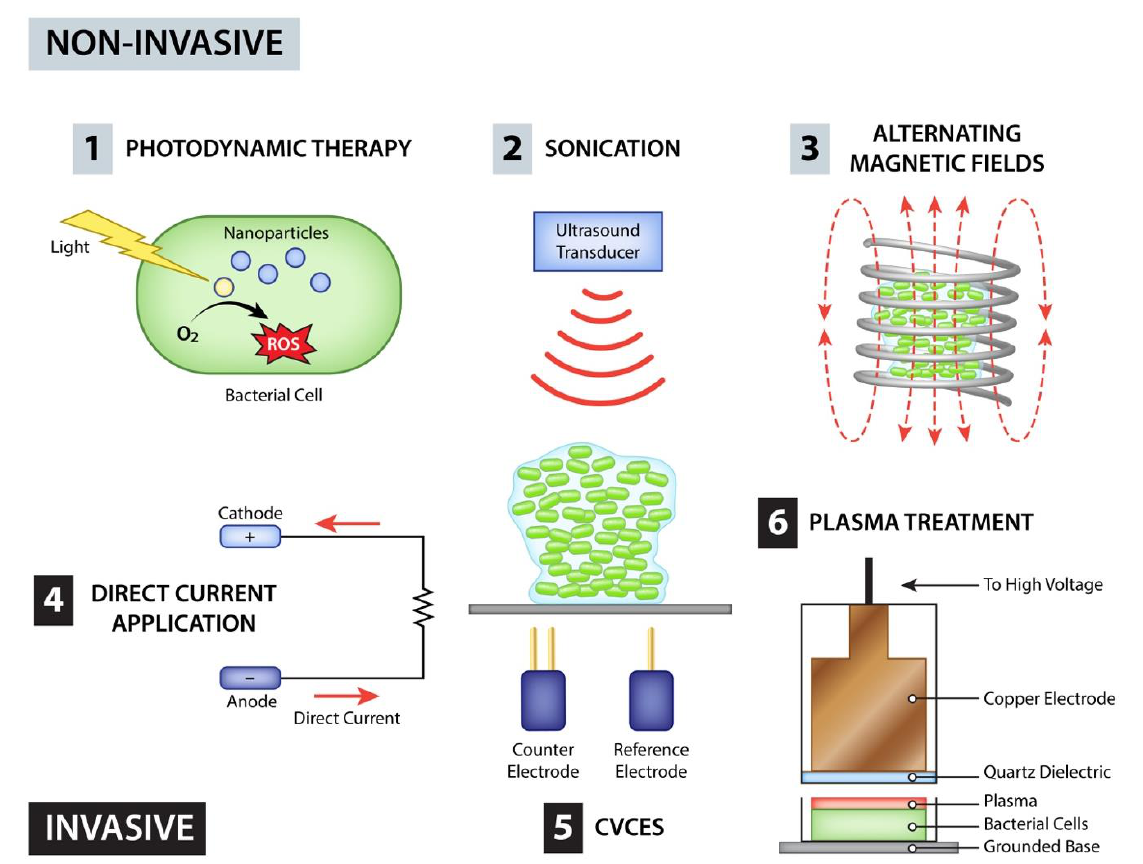
Figure 2. Summary of Extrinsic Methods. Extrinic methods of biofilm destruction can be grouped into two categories, non-invasive and invasive methods. Non-invasive methods include (1) photodynamic therapy in combination with a photosenziting substance which triggers release of ROS, (2) sonication, and (3) alternating magnetic fields causing local heating of implant surface while invasive methods include (4) direct application to the implant causing heating, (5) CVCES which utilizes two implanted electrodes plus the implant itself to create a cathodic voltage causing electrostatic repulsion and creation of ROS, and (6) plasma treatment utilizing floating electrode dielectric barrier discharge.